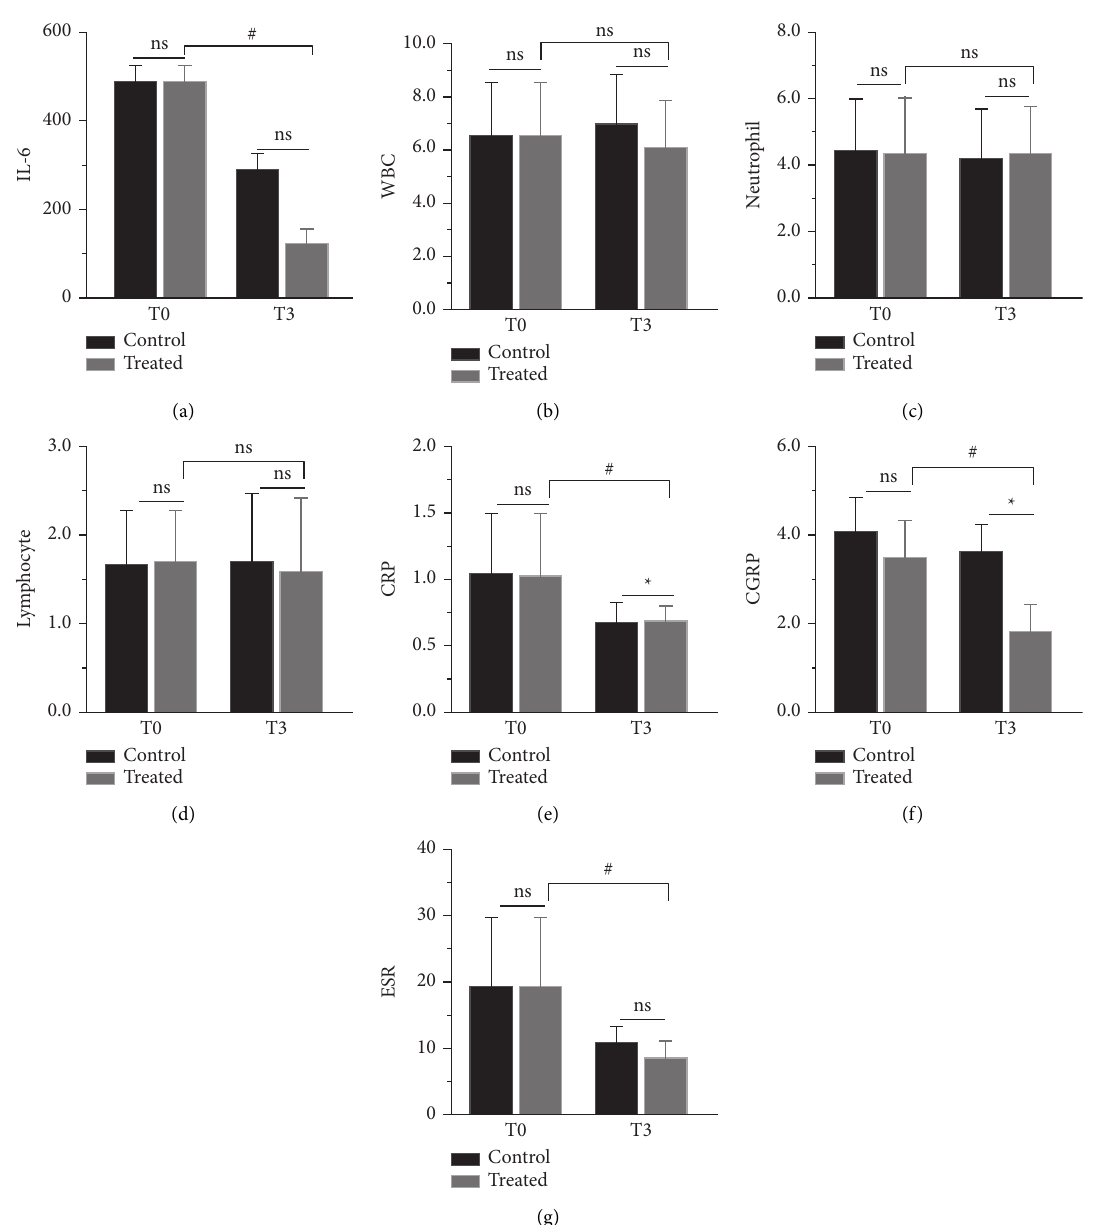
Figure 6: (a–g) Comparison of serum inflammatory indexes at T0 and T3 time points of before and after PRF in the two groups. Control (PRF+NS) and treated (PRF+Lidocaine); PRF � pulsed radiofrequency; NS � normal saline. Results are presented as mean ± SD. Compared to group control at a simultaneous point, ∗ P < 0 . 05. The treatment group was compared to before surgery, P < 0 .